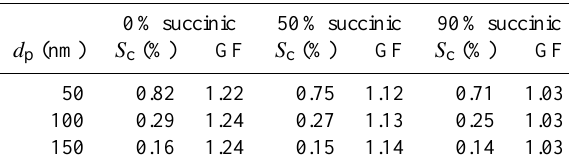
Table 3. Critical supersaturations ( S c ) and hygroscopic diameter growth factors (GF) (at 85% RH) for a particle consisting of lev- oglucosan and succinic acid in varying proportions. Calculations were made at temperature T = 293K.